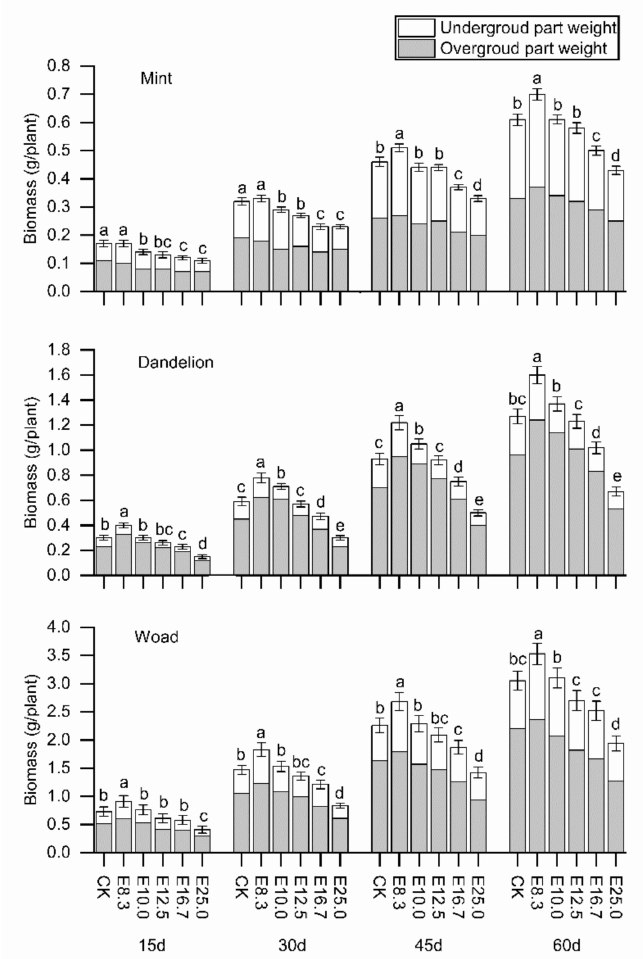
Figure 2. Effect of leaf aqueous extract of fig tree on overground and underground biomass of three medicinal plants. Values are reported as mean ± SD, n = 3. CK, 0.0 g/L; E8.3, 8.3 g/L; E10.0, 10.0 g/L; E12.5, 12.5 g/L; E16.7, 16.7 g/L; E25.0, 25.0 g/L. Lowercase letters represent significant differences in each treatment group ( p <